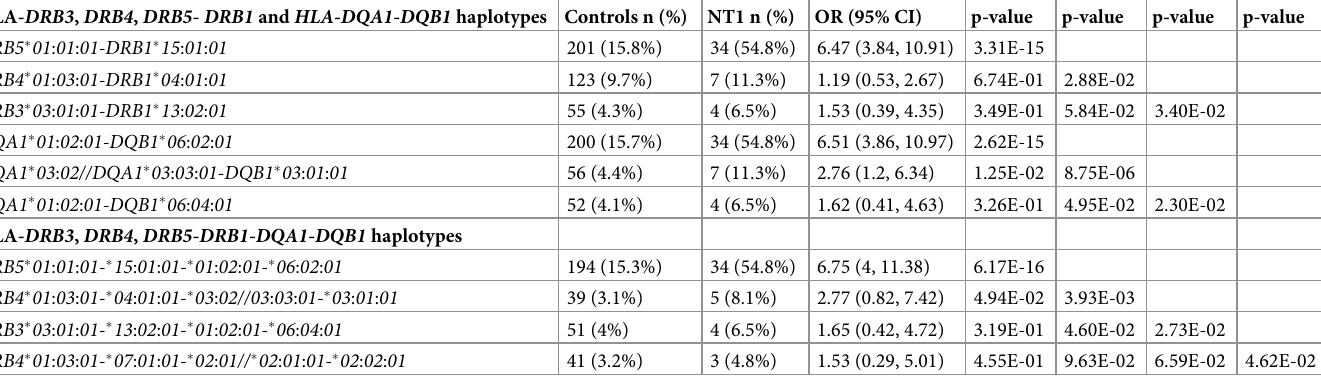
The high-resolution HLA typing revealed a total of 26 different HLA - DRB3 , DRB4 , and DRB5-DRB1-DQA1-DQB1 haplotypes among NT1 patients and GP ( > 1%) (S10 Table); in GP, 88 haplotypes at a frequency lower than 1% were found (S11 Table). Table 2. HLA-DRB3 , DRB4 , and DRB5-DRB1-DQA1-DQB1 haplotype frequencies among NT1 patients (n = 31) and population controls (n = 636). HLA- DRB3 , DRB4 , DRB5- DRB1 and HLA-DQA1-DQB1 haplotypes Controls n (%) NT1 n (%) OR (95%